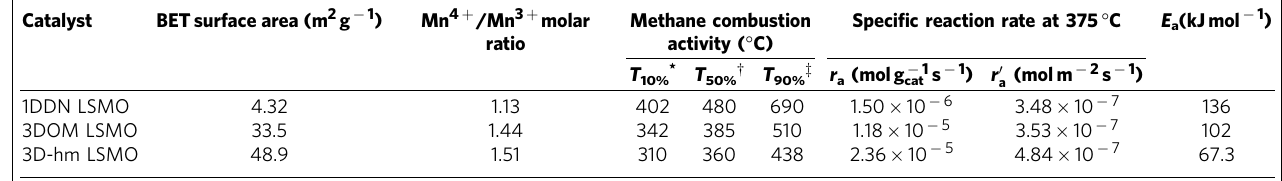
3DOM, three-dimensionally ordered macroporous; 1DDN, 1D nonporous; 3D-hm LSMO, 3D-hm La 0.6 Sr 0.4 MnO 3 ; E a , activation energy. *The temperatures required for 10% methane conversion. w The temperatures required for 50% methane conversion. z The temperatures required for 90% methane conversion.